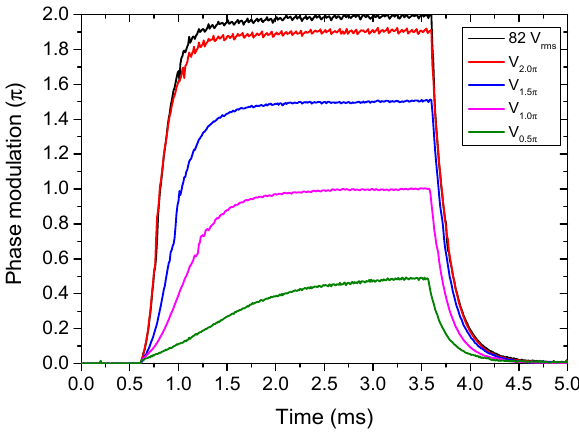
Figure 8 . Measurements of response time in the RM5N2 cell for operating phase modulations. Figure 8. Measurements of response time in the RM5N2 cell for operating phase